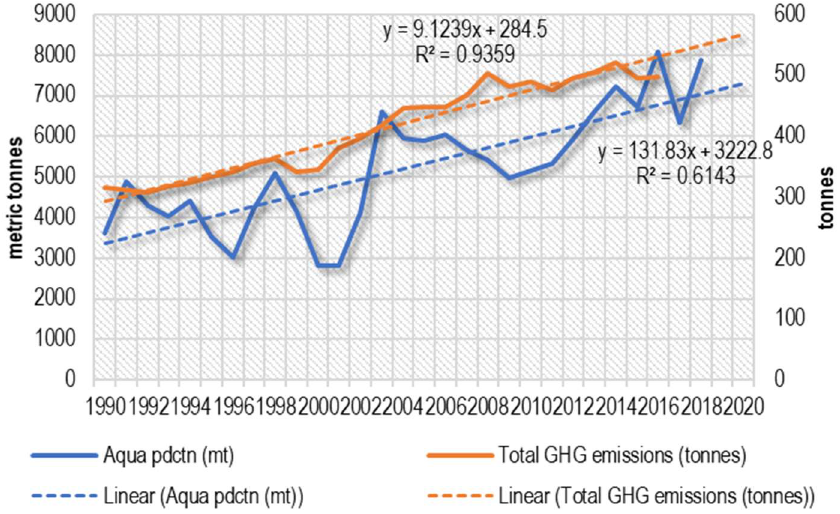
Figure 3. Aquaculture production and greenhouse gas emissions in South Africa (1990–2020).